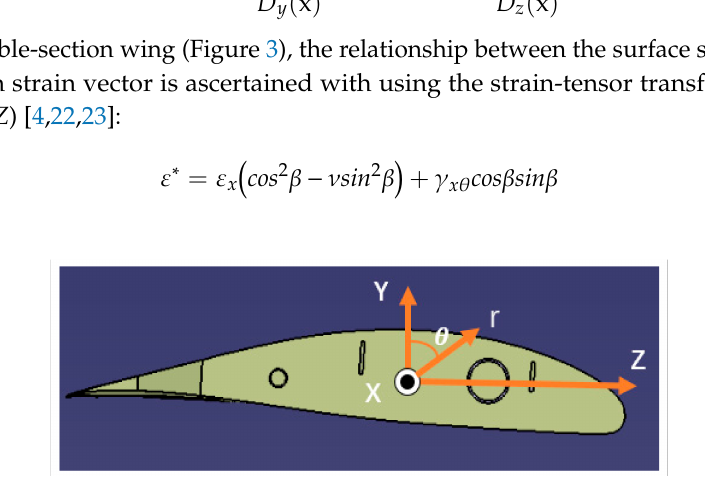
Figure 3. Orthogonal and cylindrical coordinate systems of the wing